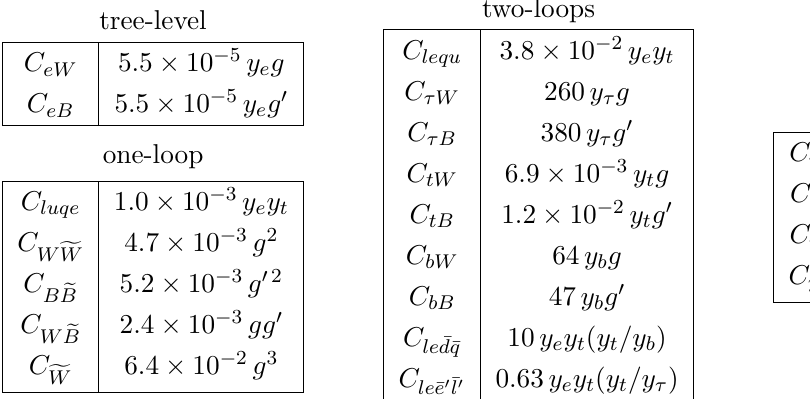
and C we have further le (cid:22) d (cid:22) q le (cid:22) e 0 (cid:22) l 0